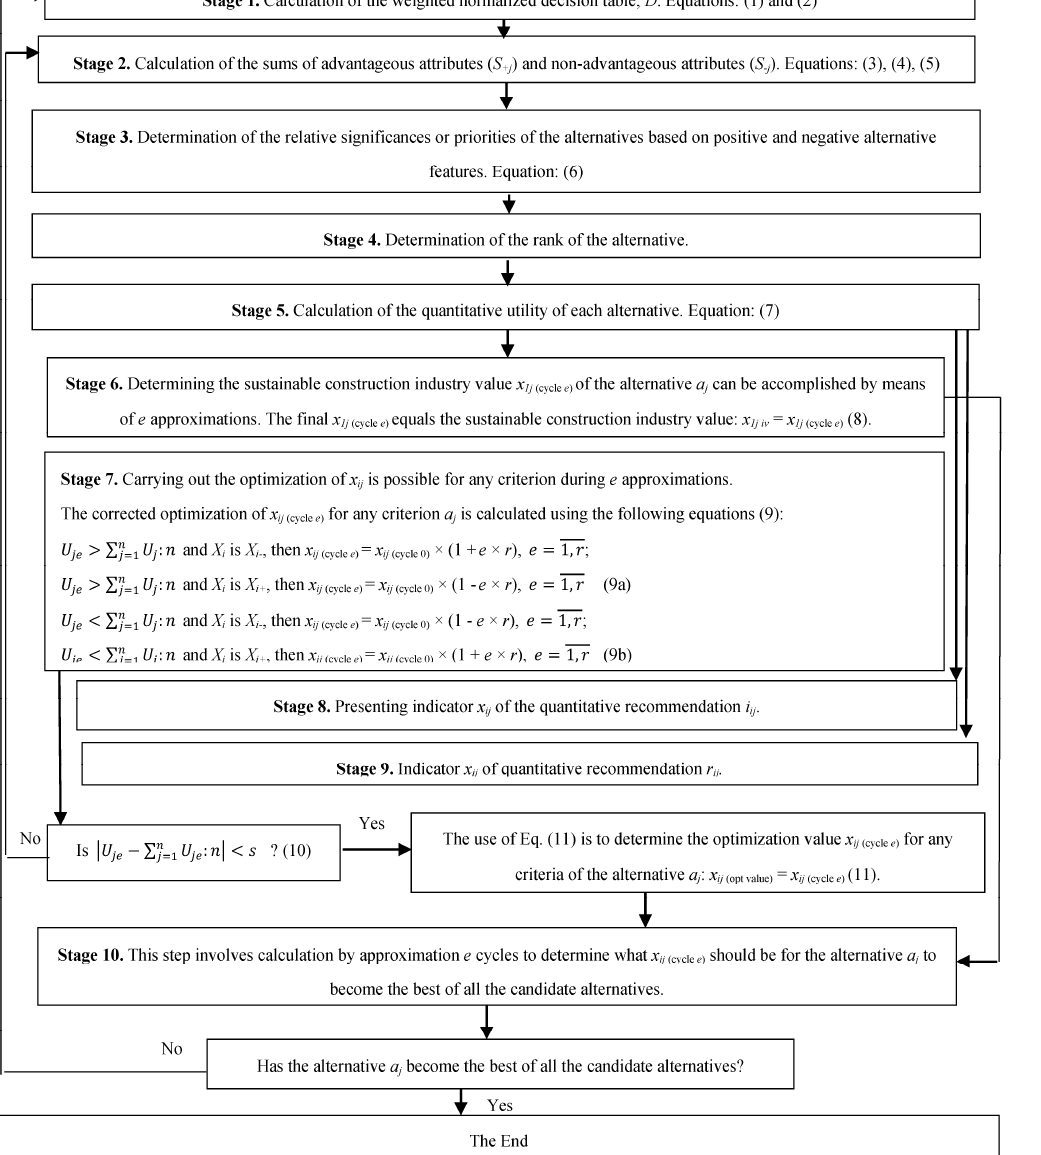
Table 1. Data from different databases.